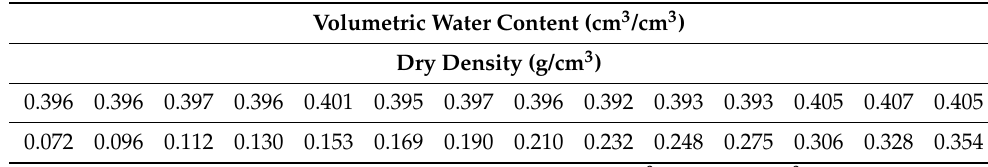
Figure 3. Impact of changes in volumetric water content on measured complex conductivity of substrate. ( a ) Nyquist plots; ( b ) magnitude spectra; ( c ) phase spectra; ( d ) in-phase conductivity spectra; ( e ) quadrature conductivity spectra. For the spectra marked by different colors, the variable volumetric water contents are provided in ( a ), while the related dry densities (Table 1) are considered to be nearly equal. The frequency range is from 20 Hz to 2 MHz. Table 1. Volumetric water contents of a typical set of substrates at nearly equal dry densities